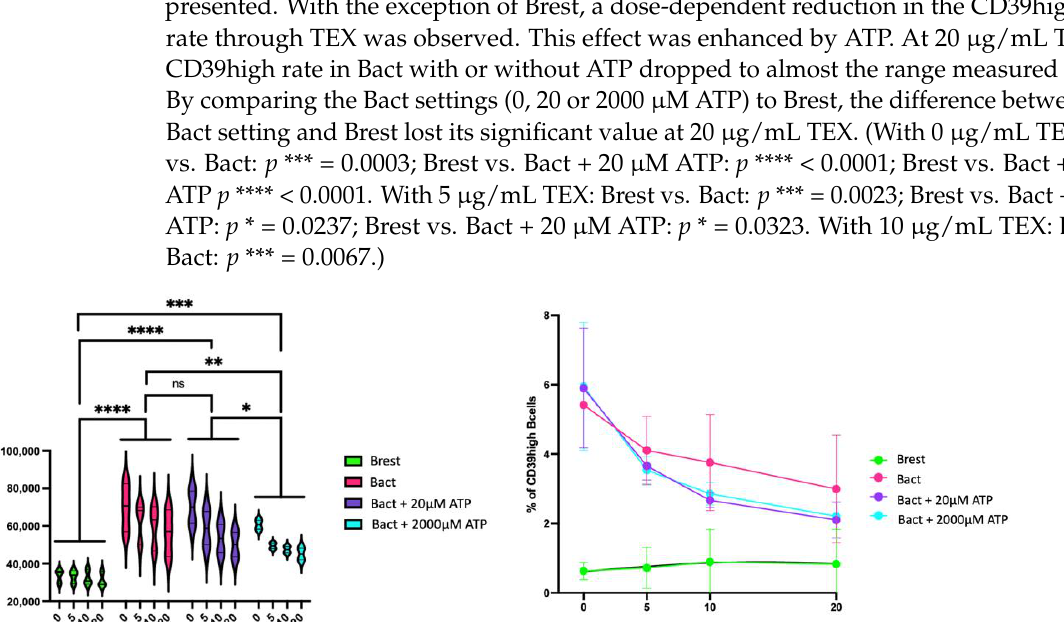
Dunnett’s multiple comparisons test. The results of three independent experiments are